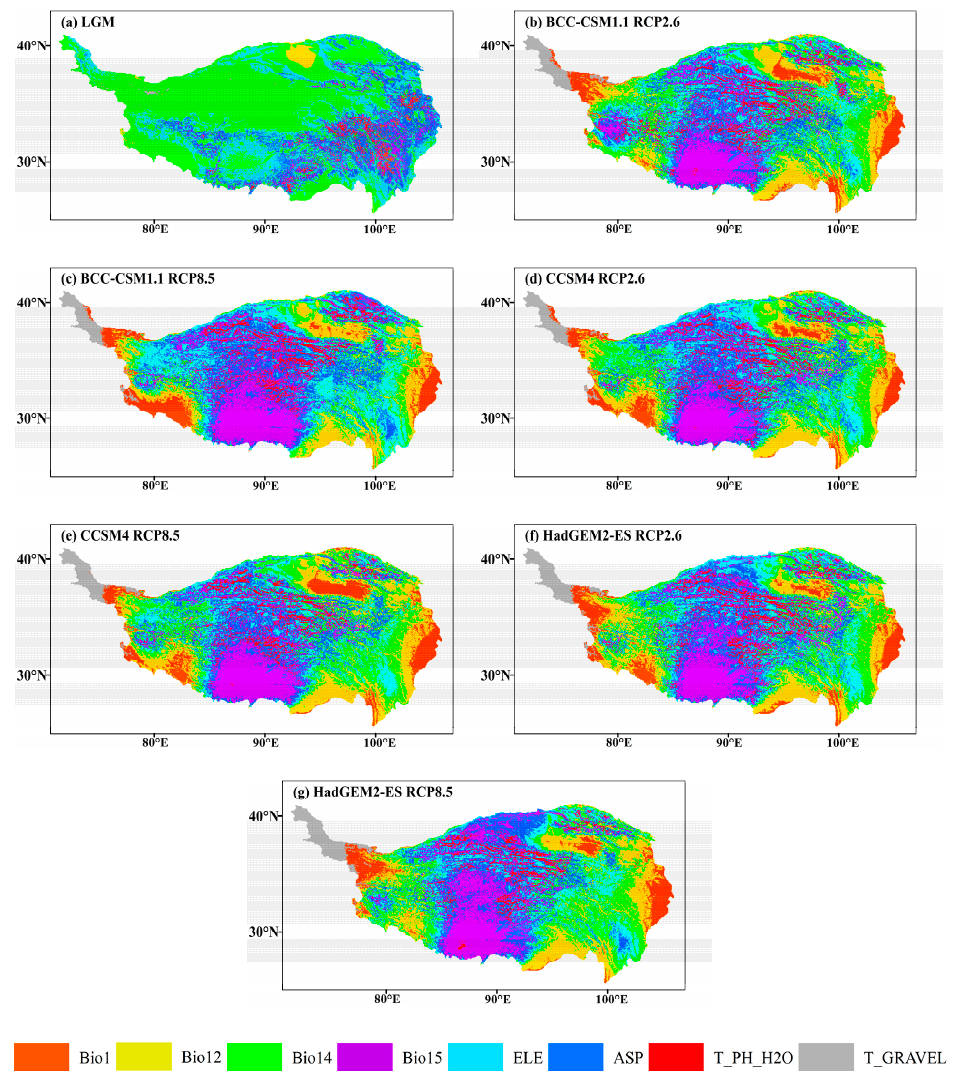
Figure 10. The most dissimilar (MoD) variable analysis for J. tibetica during different periods. ( a ) MoD for the LGM; ( b ) MoD for the BCC-CSM1.1 (RCP2.6); ( c ) MoD for the BCC-CSM1.1 (RCP8.5); ( d ) MoD for the CCSM4 (RCP2.6); ( e ) MoD for the CCSM4 (RCP8.5); ( f ) MoD for the HadGEM2-ES (RCP2.6); ( g ) MoD for the HadGEM2-ES (RCP8.5).